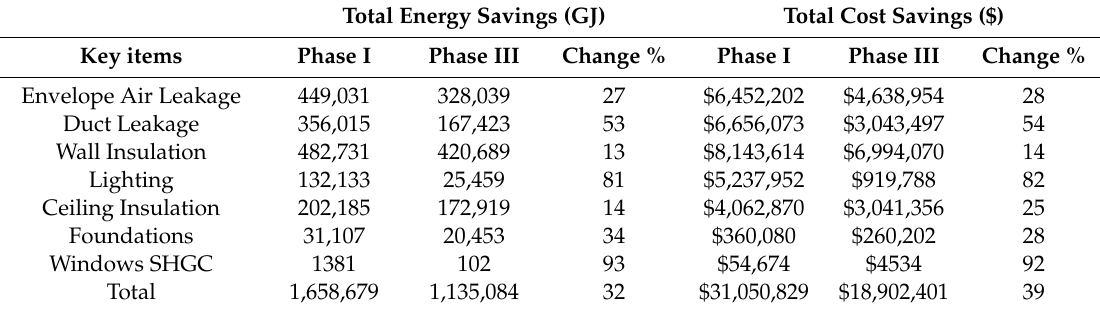
Table 5. Measure-Level Annual Savings Potential (Phase III vs. Phase I) across